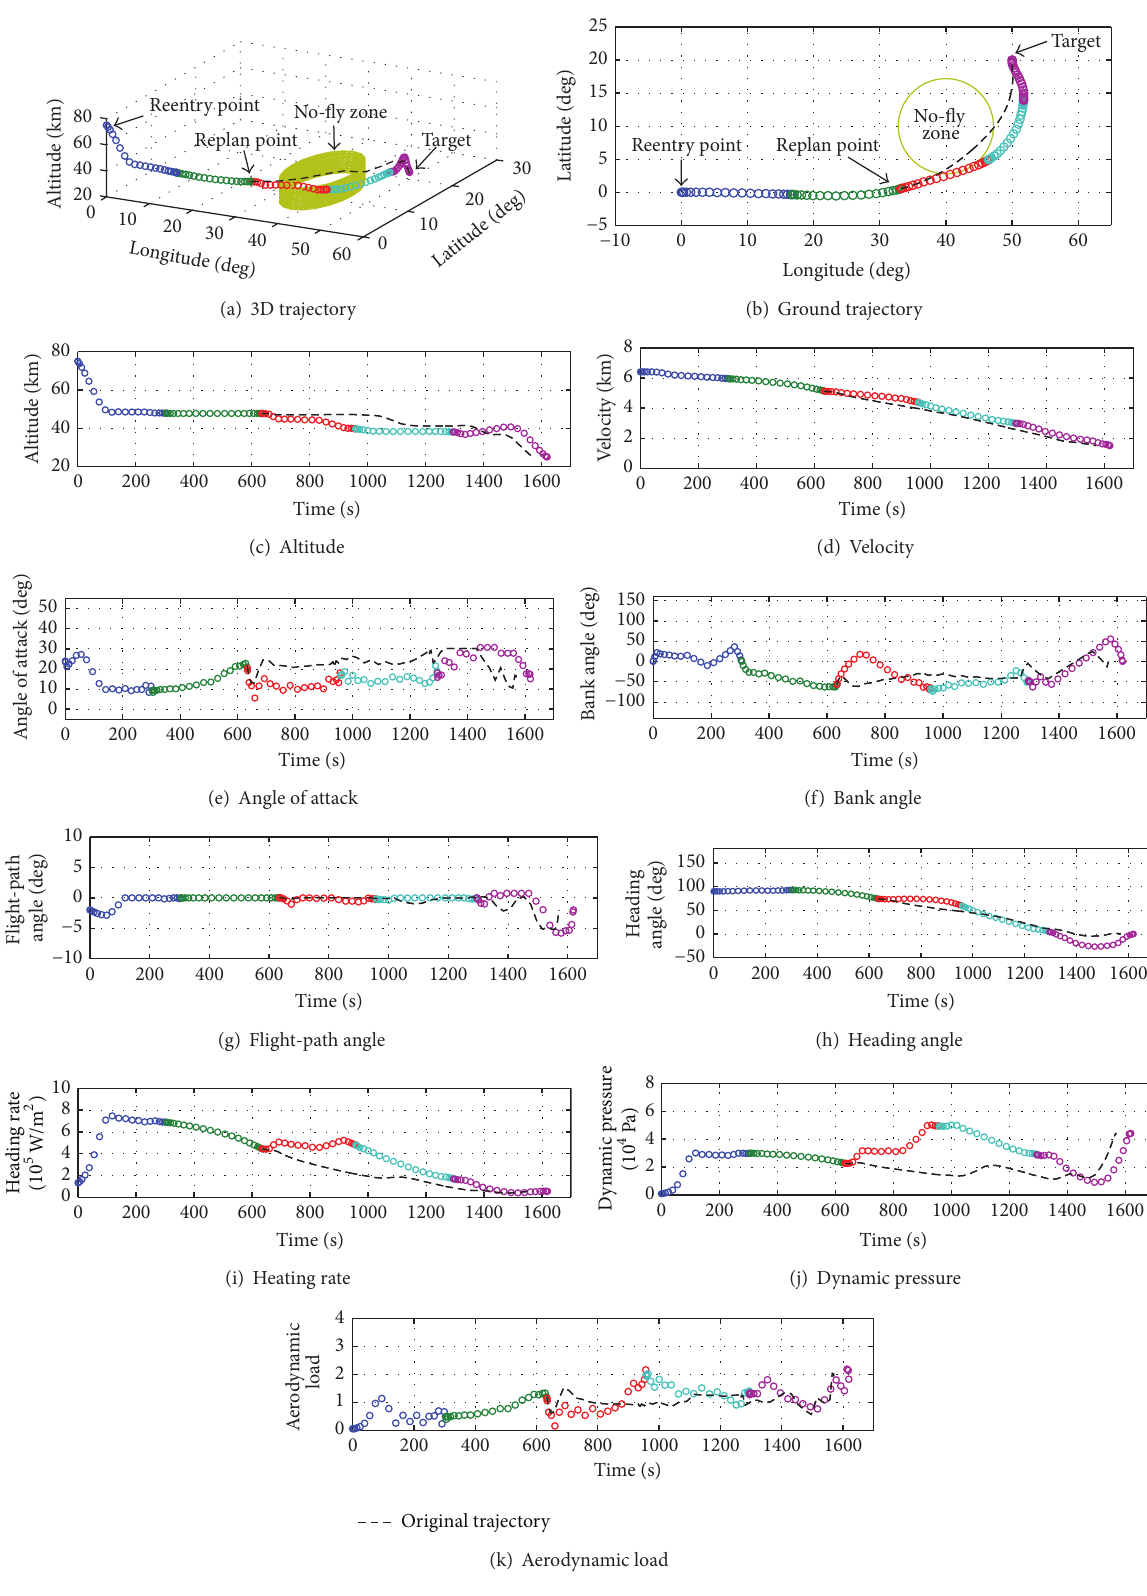
Figure 7: Numerical results of the threat avoidance